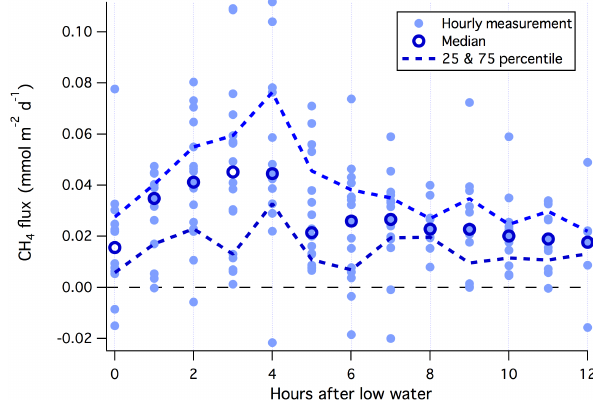
Figure 16. Hourly CH 4 flux from the south-west wind sector (R3 sonic anemometer) vs. hours after low water (18ma.m.s.l.). Ele- vated CH 4 emissions are observed in the first ∼ 4h after low tide, consistent with an enhanced source of CH 4 in the Tamar estuarine outflow driven by the local tidal